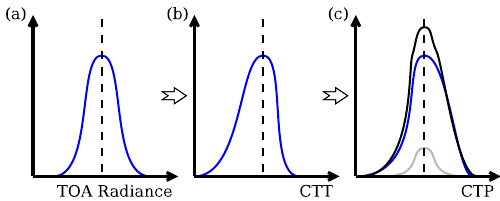
Figure 2. Distortion of the distribution of error for different selec- tions of measurand when observing a cloud. (Non-linearities exag- gerated for illustration.) (a) Measured TOA radiance suffers ran- dom errors, which have a symmetric distribution. (b) Transforma- tion with the Planck function warps the distribution when reporting cloud top temperature. (c) These are further distorted when cloud top pressure is calculated. An additional error (grey; not to scale) is introduced by the auxiliary data used in that calculation, giving an irregular total distribution